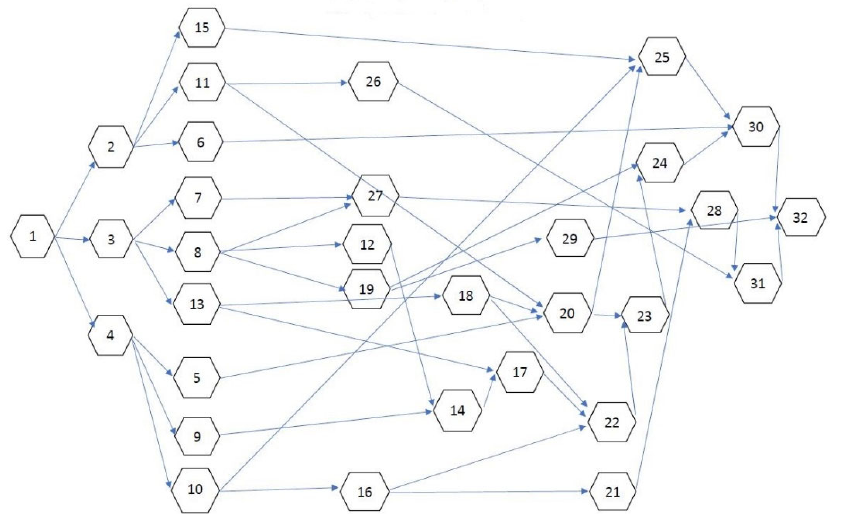
Fig 1 . An example of an Activity-on-Node (AoN) network representing a project with 32 activities. Activities 1 and 32 are dummy activities with zero duration. The simple project was selected from the projects of the PSPLIB The resource-constrained project scheduling problem (RCPSP) is academically similar to the introduced process called develop schedule to obtain project schedule . The RCPSP focuses on creating an activity sequence to optimize and minimize project duration under resource